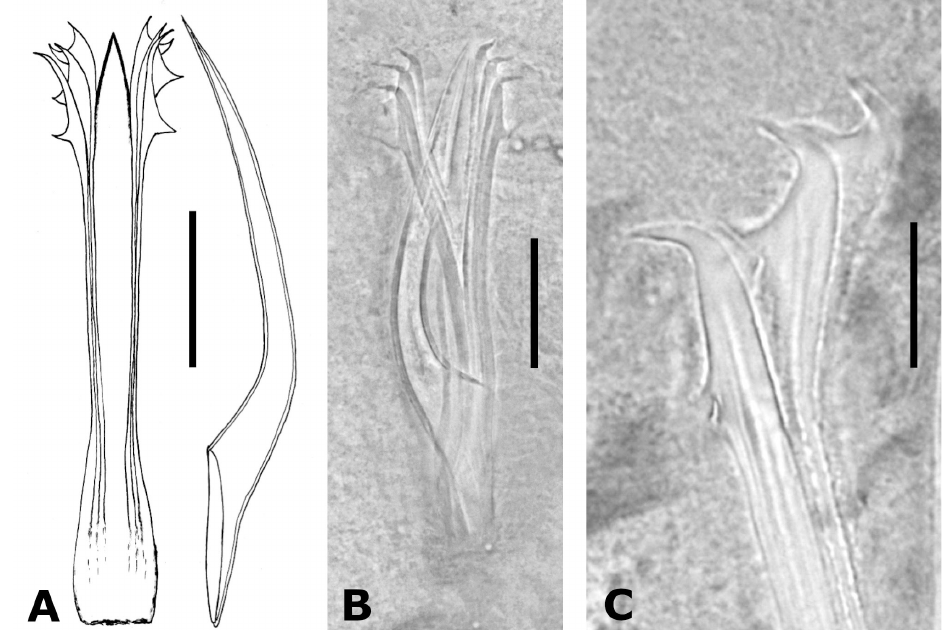
Fig. 4. Sclerotised copulatory system of Coelogynopora kenichii sp. nov. A . Schematic depiction of the stylet and the three pairs of spines (RMNH.VER.19980.p). B . Photomicrograph of the stylet and the three pairs of spines (RMNH.VER.19980.n). C . Photomicrograph of the distal portion of the three spines on one side of the stylet, showing their different morphologies (RMNH.VER.19980.o). Scale bars: A–B = 25 µm; C = 10